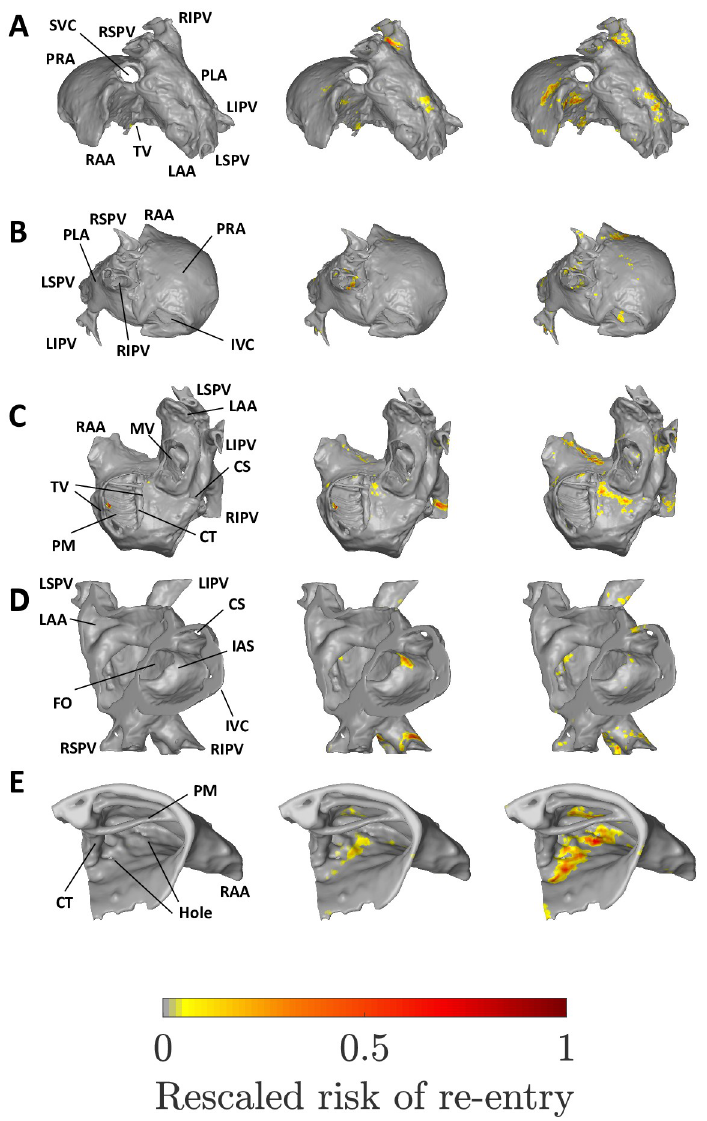
Fig 5. The micro-reentrant substrate for the human atria at low (left column), medium (middle) and high global risk of micro-reentry (right). A: Superior view. B: Posterior view. C: Inferior view. D: Cut-through. E: Superior right atrial zoom. IVC/SVC: Inferior/superior vena cava. PRA/PLA: Posterior right/left atrium. RAA/LAA: Right/left atrial appendage. TV/MV: Tricuspid/mitral valve opening. CS: Coronary sinus. FO: Fossa ovalis. PM: Pectinate muscles. CT: Crista terminalis. IAS: Inter-atrial septum. RIPV/LIPV/RSPV/LSPV: Right/left, inferior/superior, pulmonary vein.